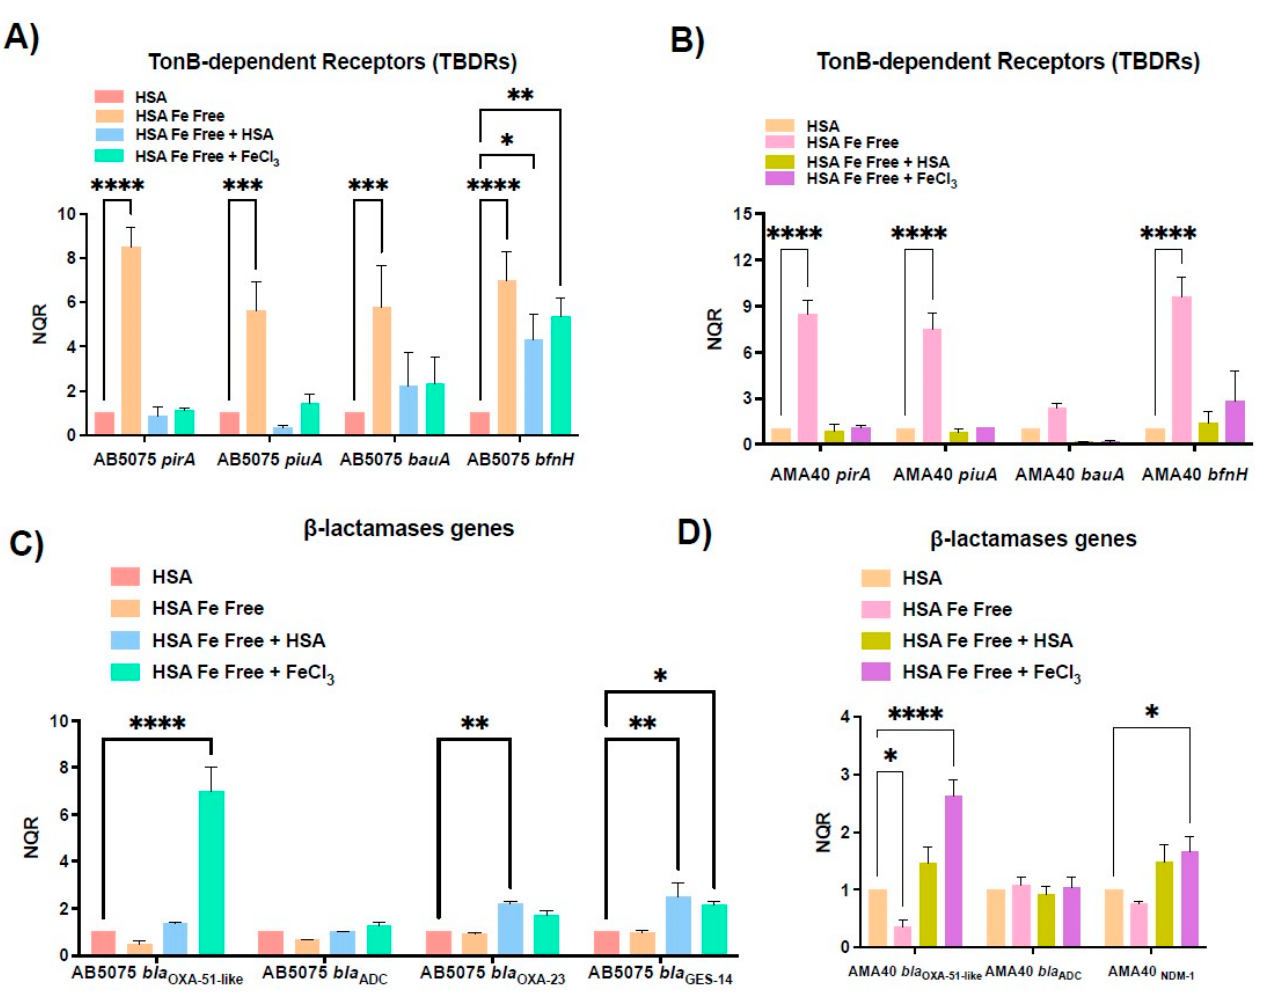
Figure 3. Expression analysis of iron uptake genes and genes coding for β -lactamases in the AB5075 ( A , C ) and AMA40 ( B , D ) strains. qRT-PCR of pirA, piuA, bauA, bfnH, bla OXA-51-like , bla ADC , bla OXA-23 , bla NDM-1 , and bla GES-11 expressed in human serum albumin (HSA), HSA Fe-free, HSA Fe-free supple- mented with FeCl 3 , or HSA Fe-free supplemented with HSA. The data shown are the means ± SD of normalized relative quantities (NRQ) obtained from transcript levels calculated via the qBASE method. This method is a modification of the classic ΔΔ Ct method used to take multiple reference genes (in this work, rpoB and recA ) and gene-specific amplification efficiencies into account. At least three independent samples were used, and four technical replicates were performed using each sample. The HSA condition was used as a reference. Statistical significance ( p < 0.05) was determined by two-way ANOVA followed by Tukey’s multiple-comparison test, one asterisk: p < 0.05; two asterisks: p < 0.01; three asterisks: p < 0.001; and four asterisks: p < 0.0001.